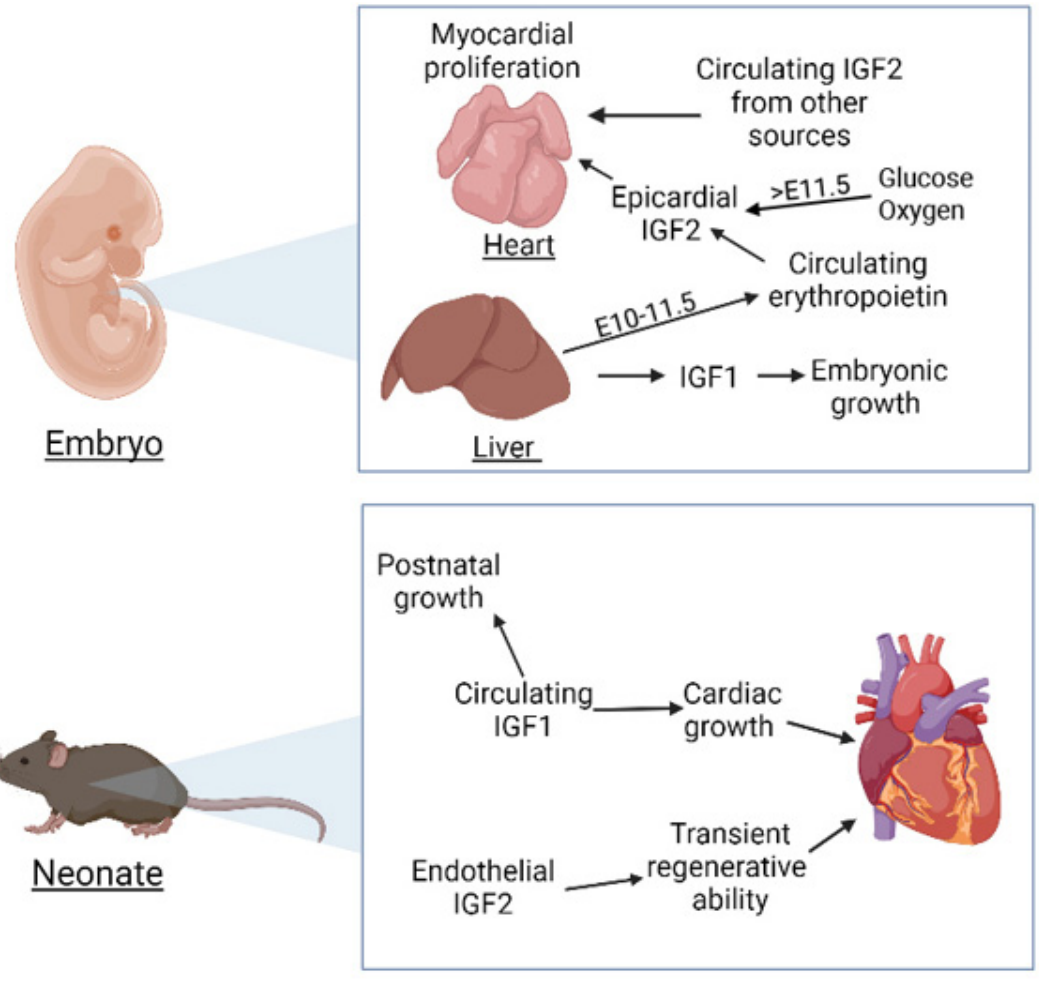
Figure 1. Main functions of the IGF signalling system in cardiac development and in the heart of neonate mice. Both cardiomyocyte proliferation and postnatal cardiac growth are regulated by this system, where IGF1 and IGF2 play different